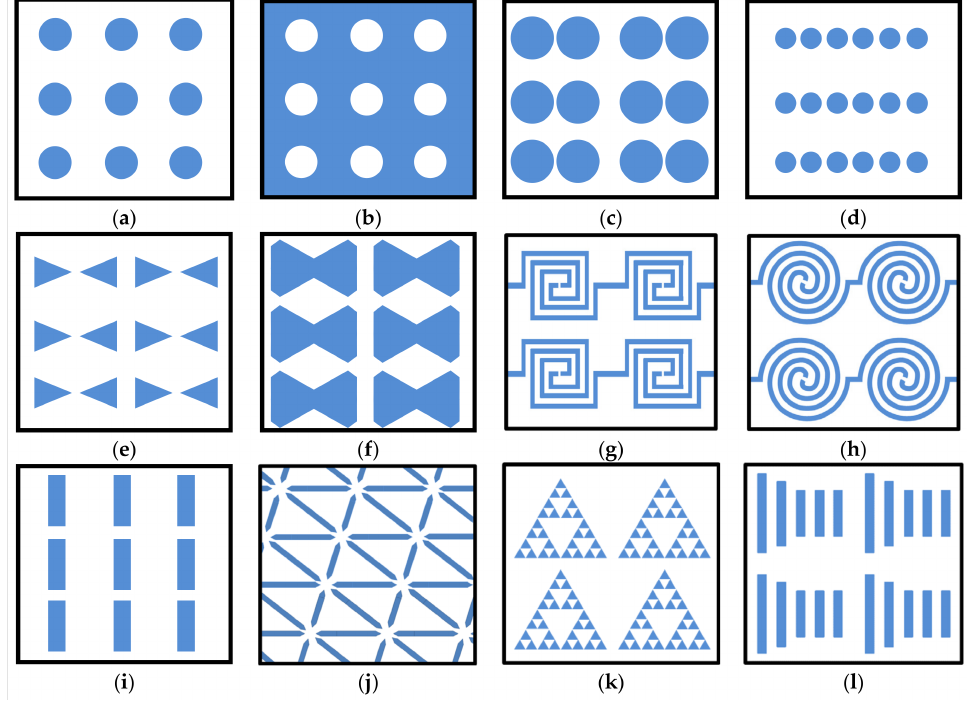
Figure 12. ( a ) Low-height conductive cylindrical scatterers acting as an array of electromagnetic dipoles on dielectric nanomembrane surface; ( b ) complementary structure to ( a ) with conductive sur- face and apertures (dielectric), designed according to Babinet principle; ( c ) nanodimers on nanomem- brane; ( d ) nanodot array (nanoparticle chain); ( e ) bowtie nanoantennas array; ( f ) diabolo array; ( g ) square spiral nanoantennas array; ( h ) round spiral nanoantennas array; ( i ) end-to-end two-wire array; ( j ) hexagonal lattice array; ( k ) Sierpinski fractal nanoantenna array; ( l ) Yagi-Uda